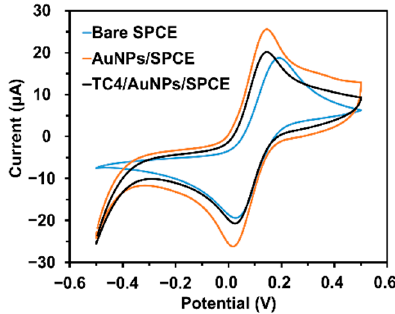
Figure 3. Cyclic voltammograms of bare SPCE, AuNPs/SPCE, and TC4/AuNPs/SPCE in 0.1 M KCl solution containing 1 mM of K 3 [Fe(CN) 6 ] at a scan rate of 100 mV/s.